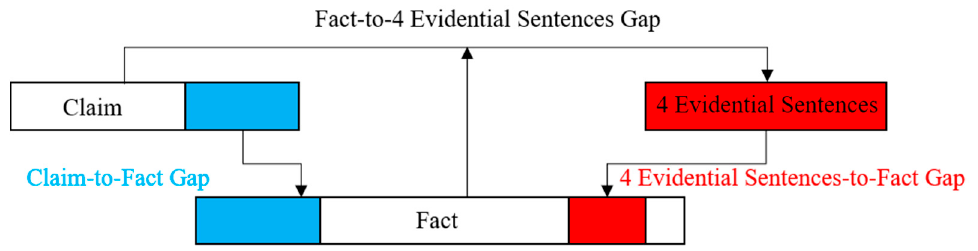
Figure 4. Overview on kinds of knowledge gaps, assuming partial knowledge from evidence.